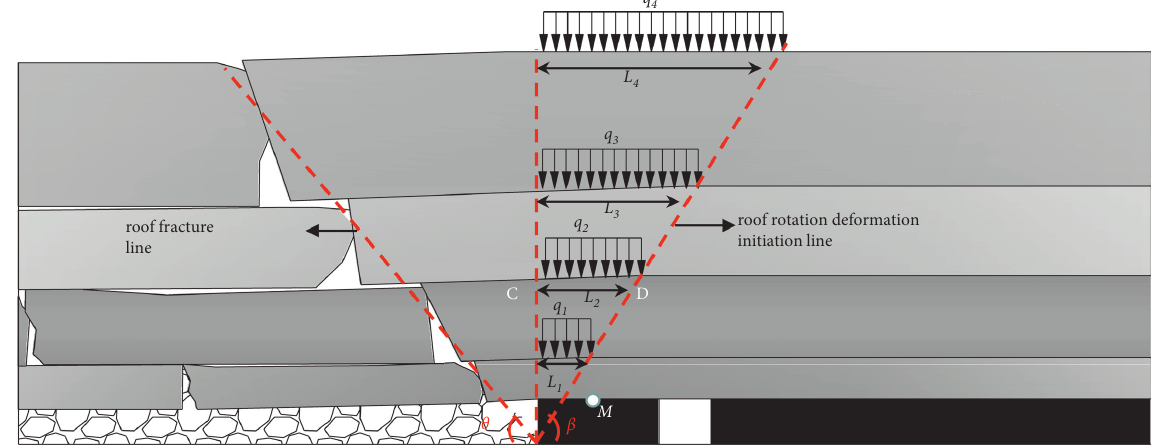
Figure. 7: Additional load distribution of the cantilevered block along the goaf